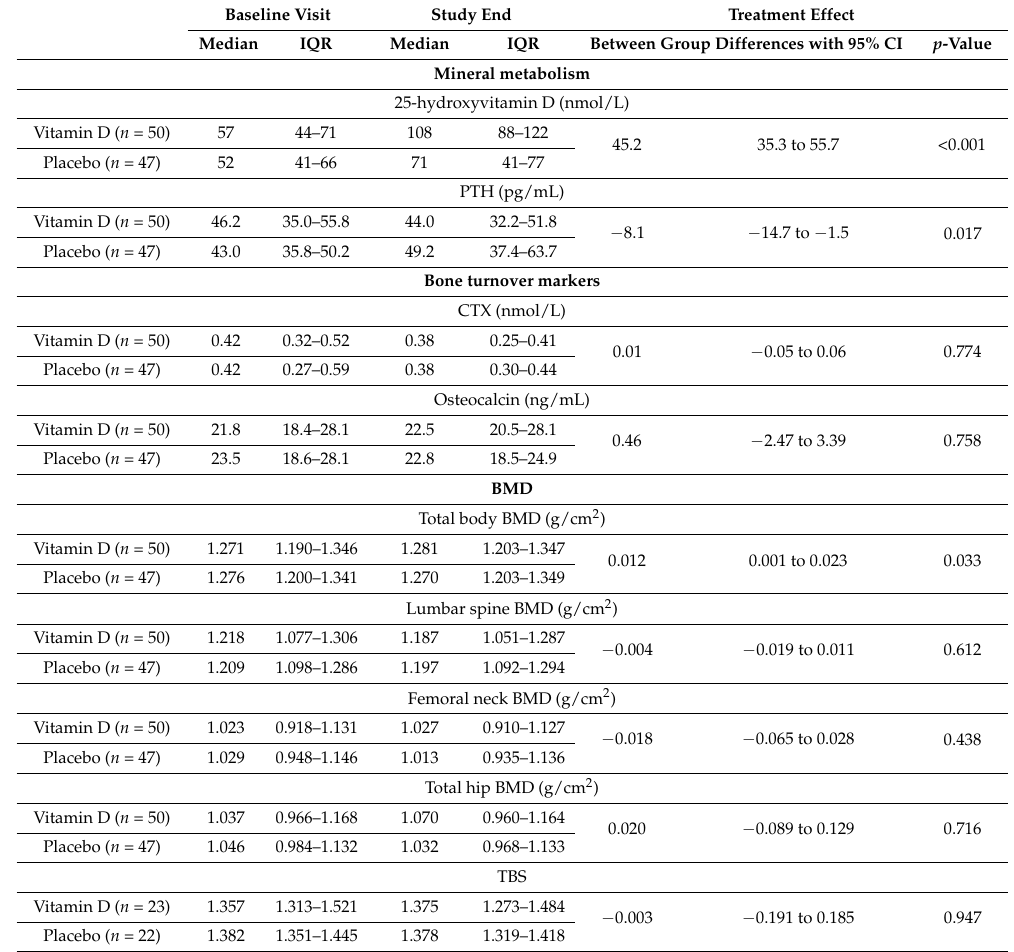
Table 4. Parameters of mineral metabolism and outcome variables at baseline and final follow-up at study end (12 weeks) in study participants with a BMI <26.4 kg/m 2 and available values at both study